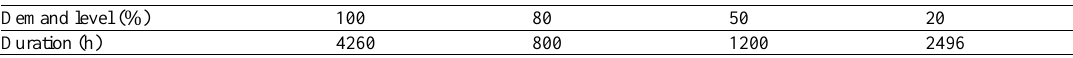
Table 10 . Parameters of the cumulative load demand curve (Example 1).